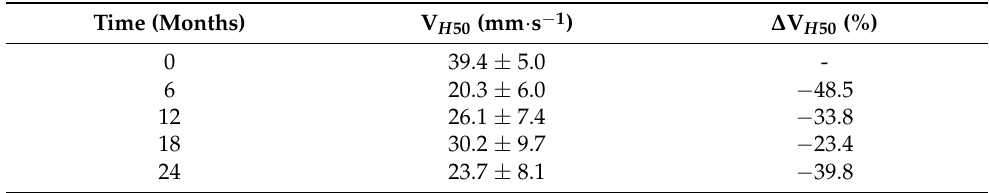
Figure 4. Mean curves head loss vs. v 20 of GT500, before and after the field weathering tests. Table 6. V H 50 of GT500 before and after the field weathering tests. (Notation: V H 50 —velocity index for a head loss of 50 mm; ∆ V H 50 —variation in V H 50